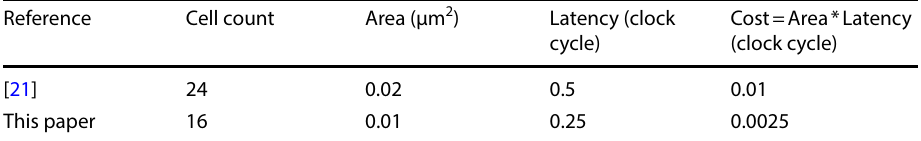
Table 3 The comparative table for the memory units